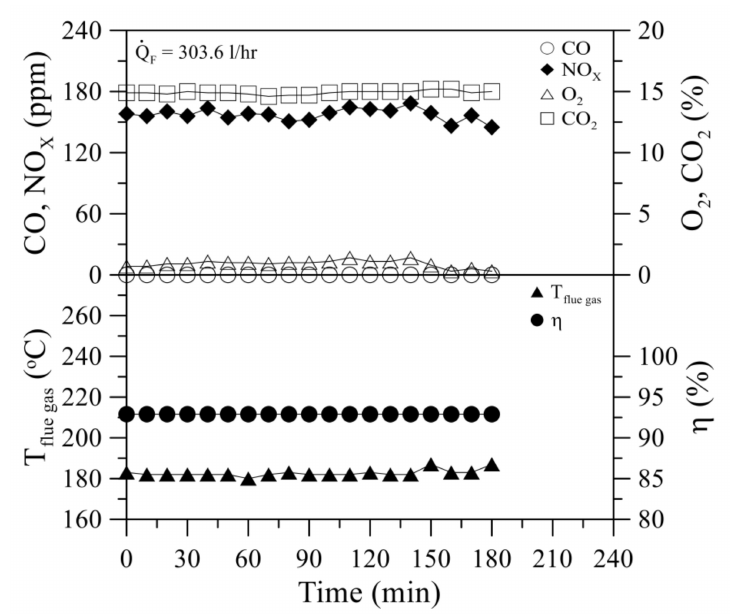
Figure 10. Combustion characteristics when firing emulsion fuel oil with 20 vol% water after cleaning the boiler tubes.